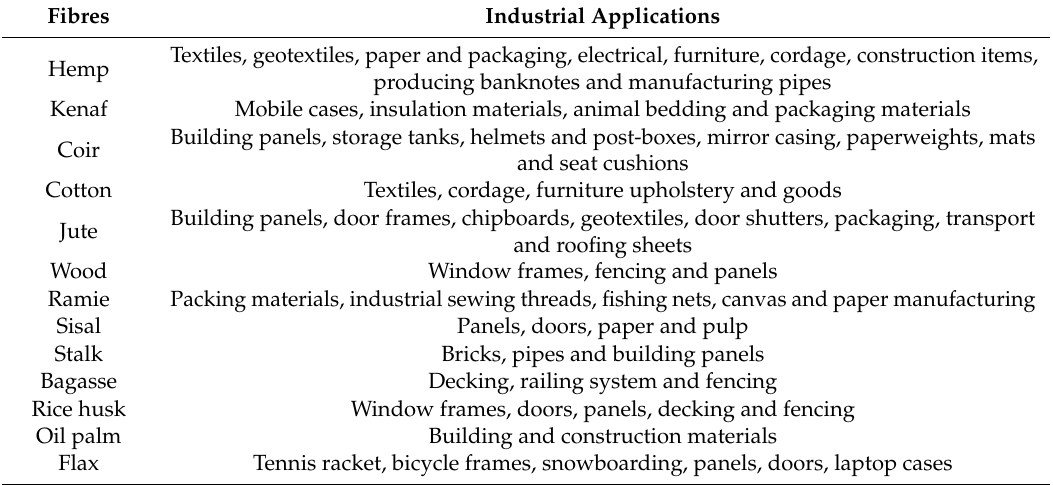
Table 8. Applications of cellulosic fibres in di ff erent industries